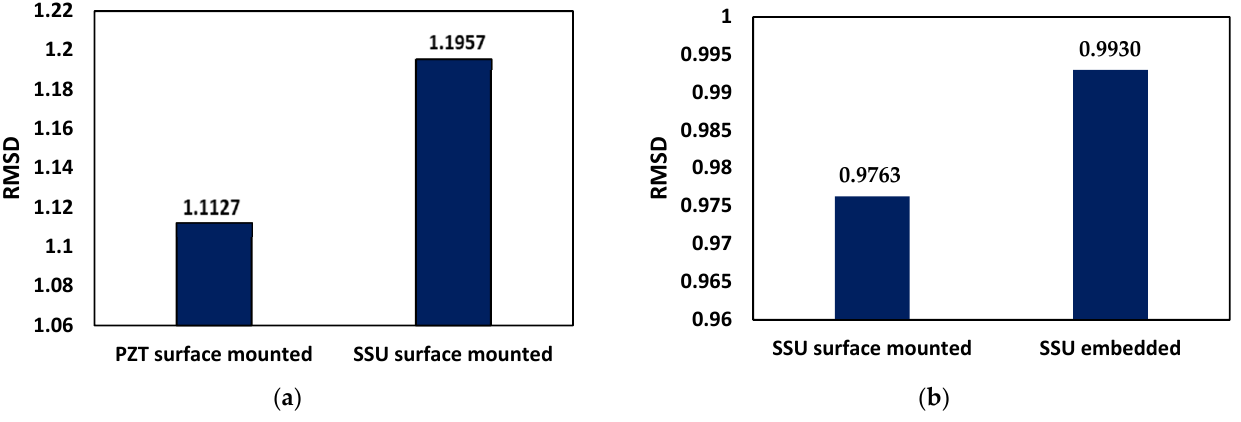
Figure 19. RMSD comparison plot for a damaged concrete beam with: ( a ) surface-mounted PZT patches (case-2) and SSUs (case-4); ( b ) surface-mounted SSUs (case-4) and embedded SSUs (case-6).